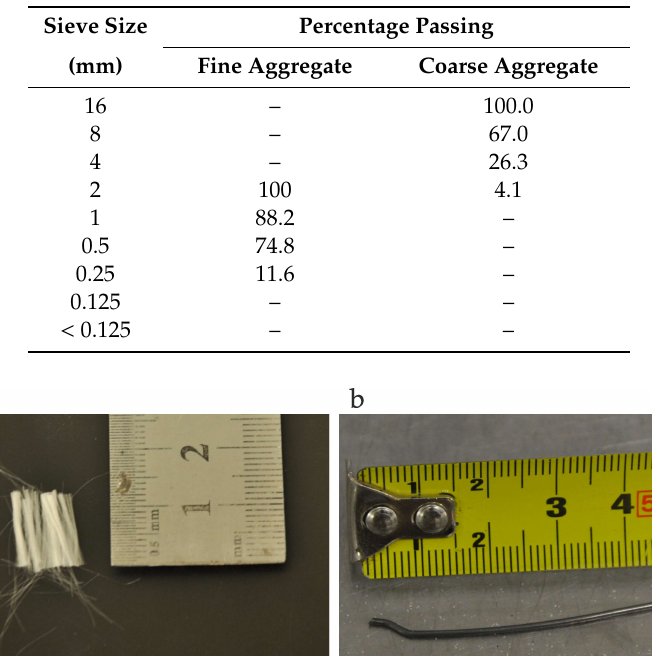
Table 2. Grading of fine and coarse aggregates.